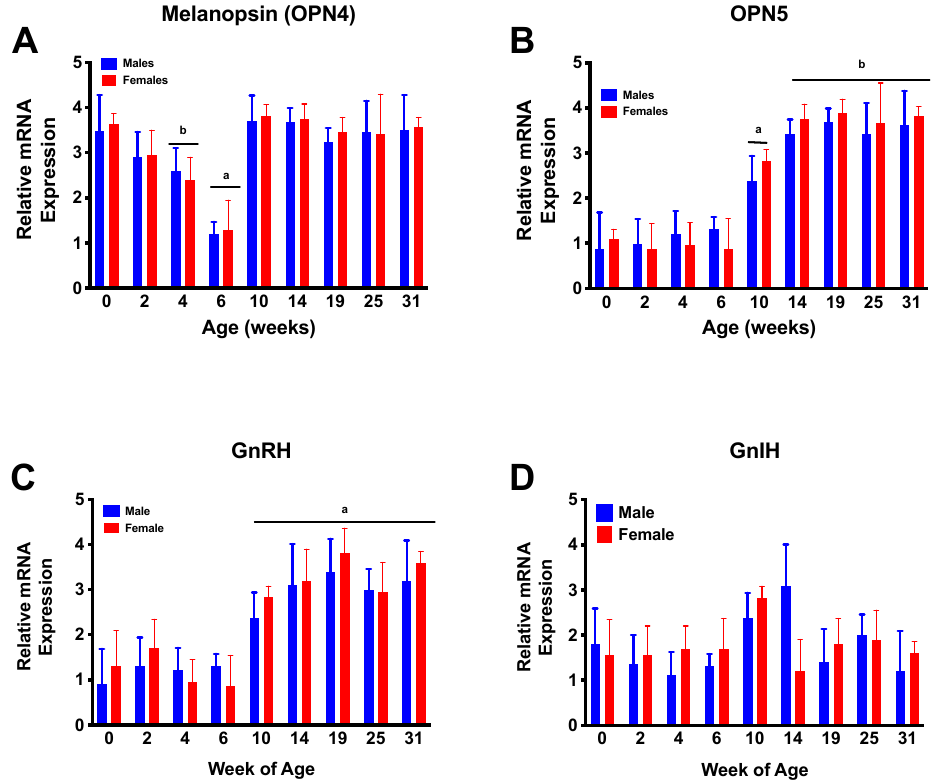
Figure 1. Ontogeny of relative mRNA expression of opsin 4 (OPN4; ( A )), opsin 5 (OPN5; ( B )), gonadotropin releasing hormone (GnRH; ( C )), and gonadotropin inhibitory hormone (GnIH; ( D )). Relative OPN4 expression was high just after hatch then dropped over the first 6 weeks of life, then once again increased prior to the increase in relative GnRH mRNA expression. OPN5 expression remained low until prior to the increase in GnRH expression. No differences were observed in GnIH relative mRNA expression at any age. Letters indicate statistically different groups at p < 0.05.